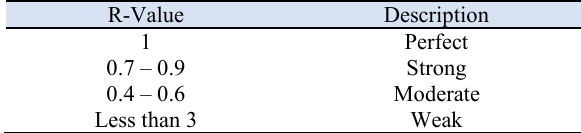
Table 2. Classification of R-values (Dancey and Reidy, 2004).